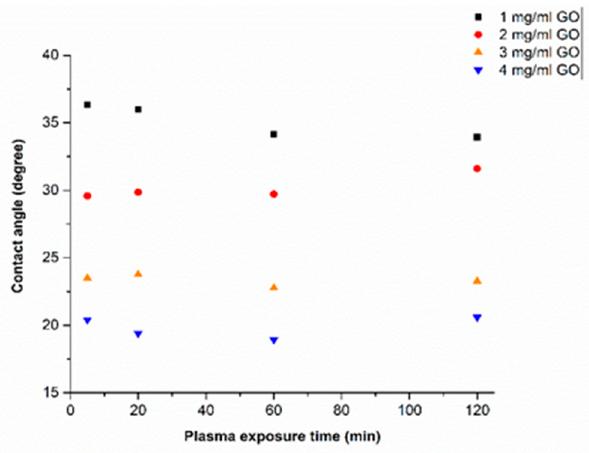
Figure 7. Variation of DI water contact angle with plasma exposure time in plasma pretreated GO − coated COC.